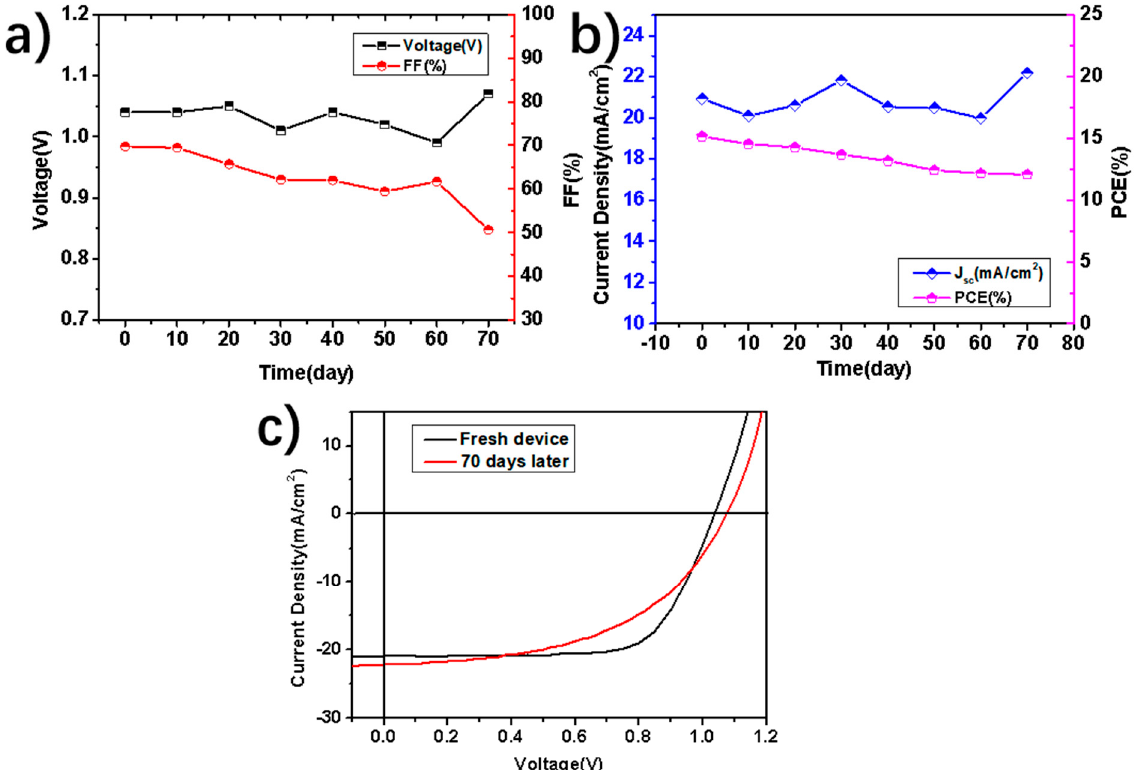
Figure 8. Long-term stability of the CIGS-based PSCs: ( a ) V oc and FF, and ( b ) J sc and PCE degradation of storage time in an inert atmosphere without encapsulation and tested in the air. ( c ) J-V curves of the fresh device and the same one after aging 70 days.